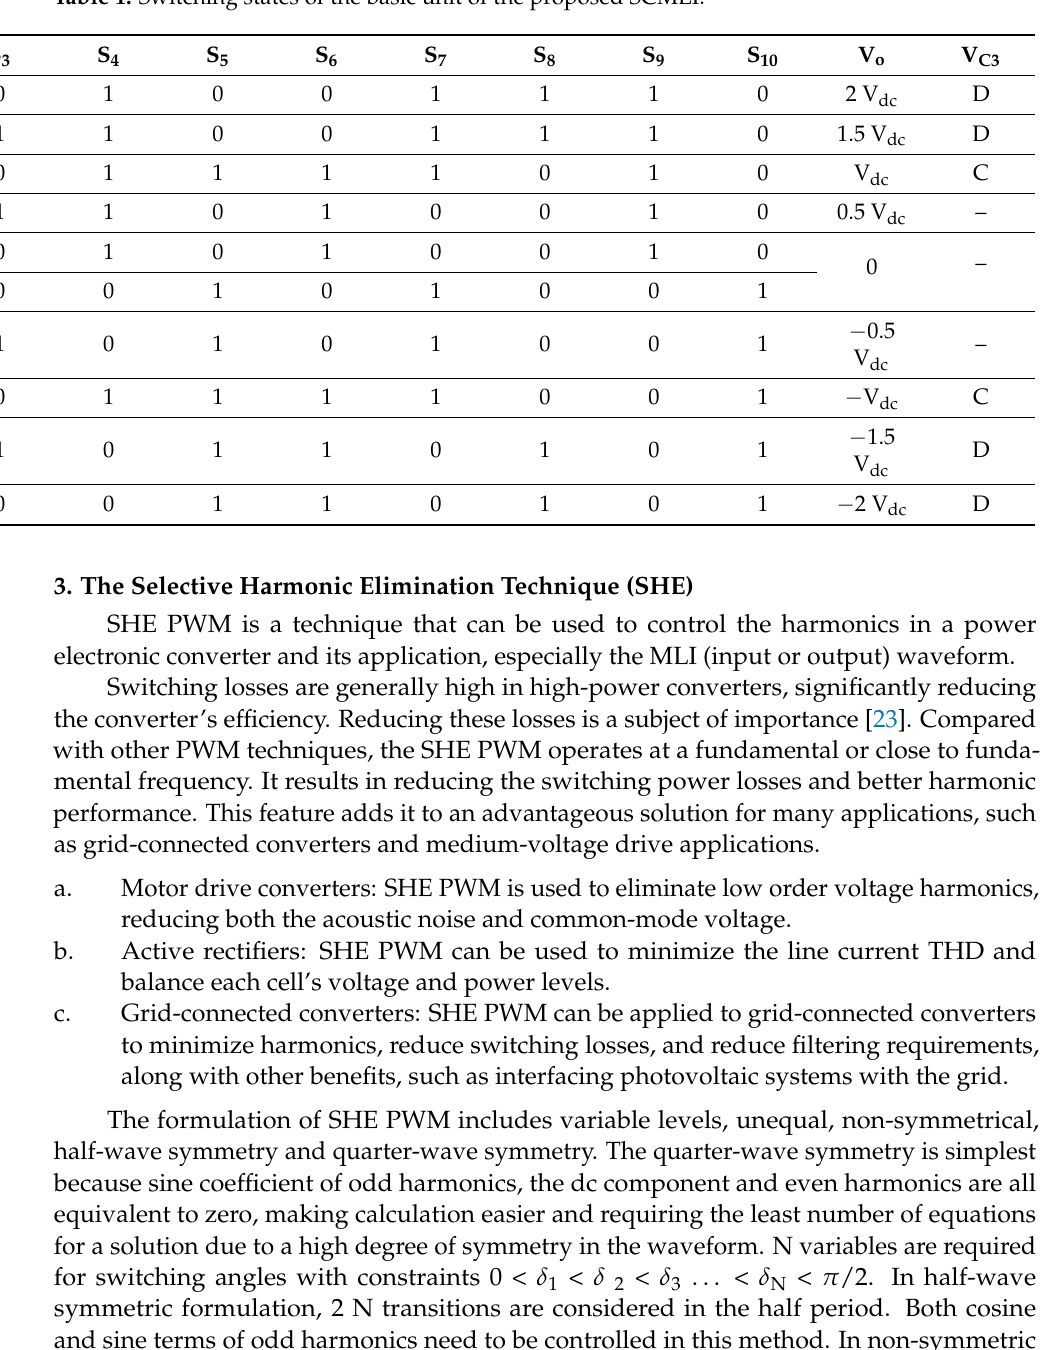
Table 1. Switching states of the basic unit of the proposed